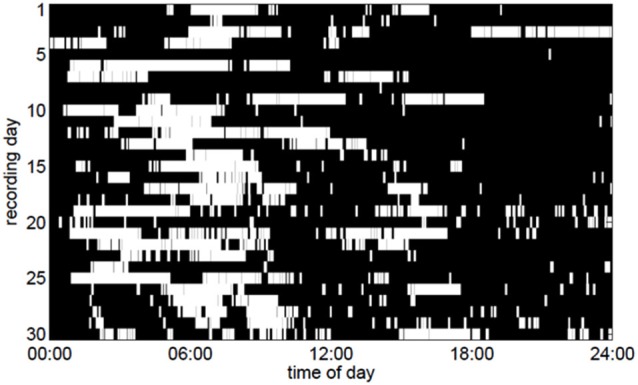
Periods of slow-wave activity (white pixels) in the ECoG as a function of the time of day over a period of 30 days. To make the figure clearer, only slow-wave periods lasting for at least 5 min are depicted here.